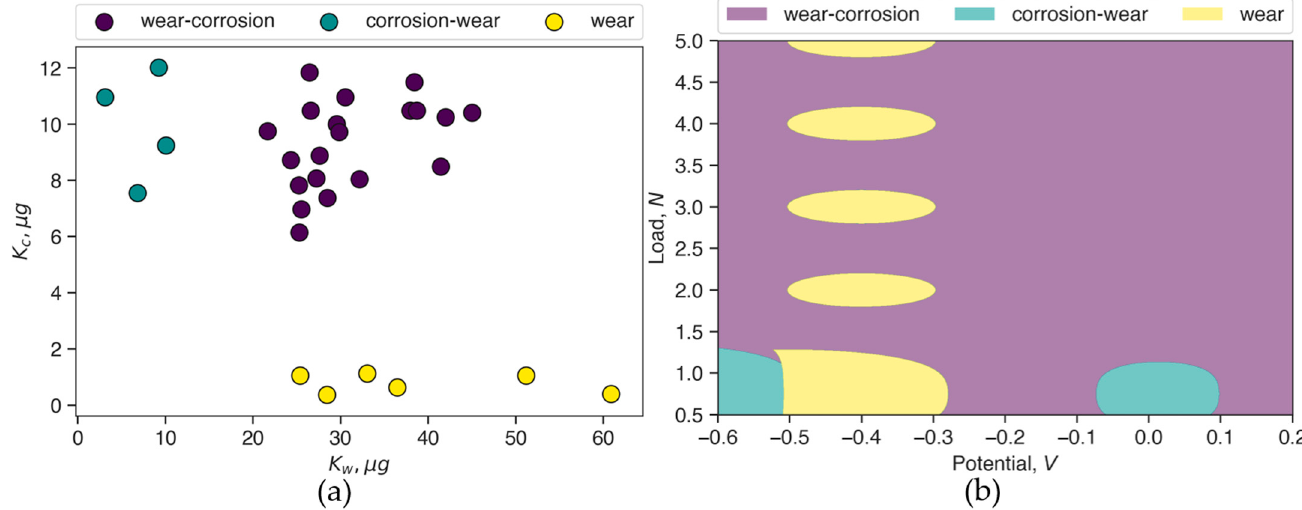
Figure 3. ( a ) Three clusters in dataset 1 identified using K -means clustering; and ( b ) the tribocorrosion mechanism map using support vector machines (SVMs) for the titanium alloy.